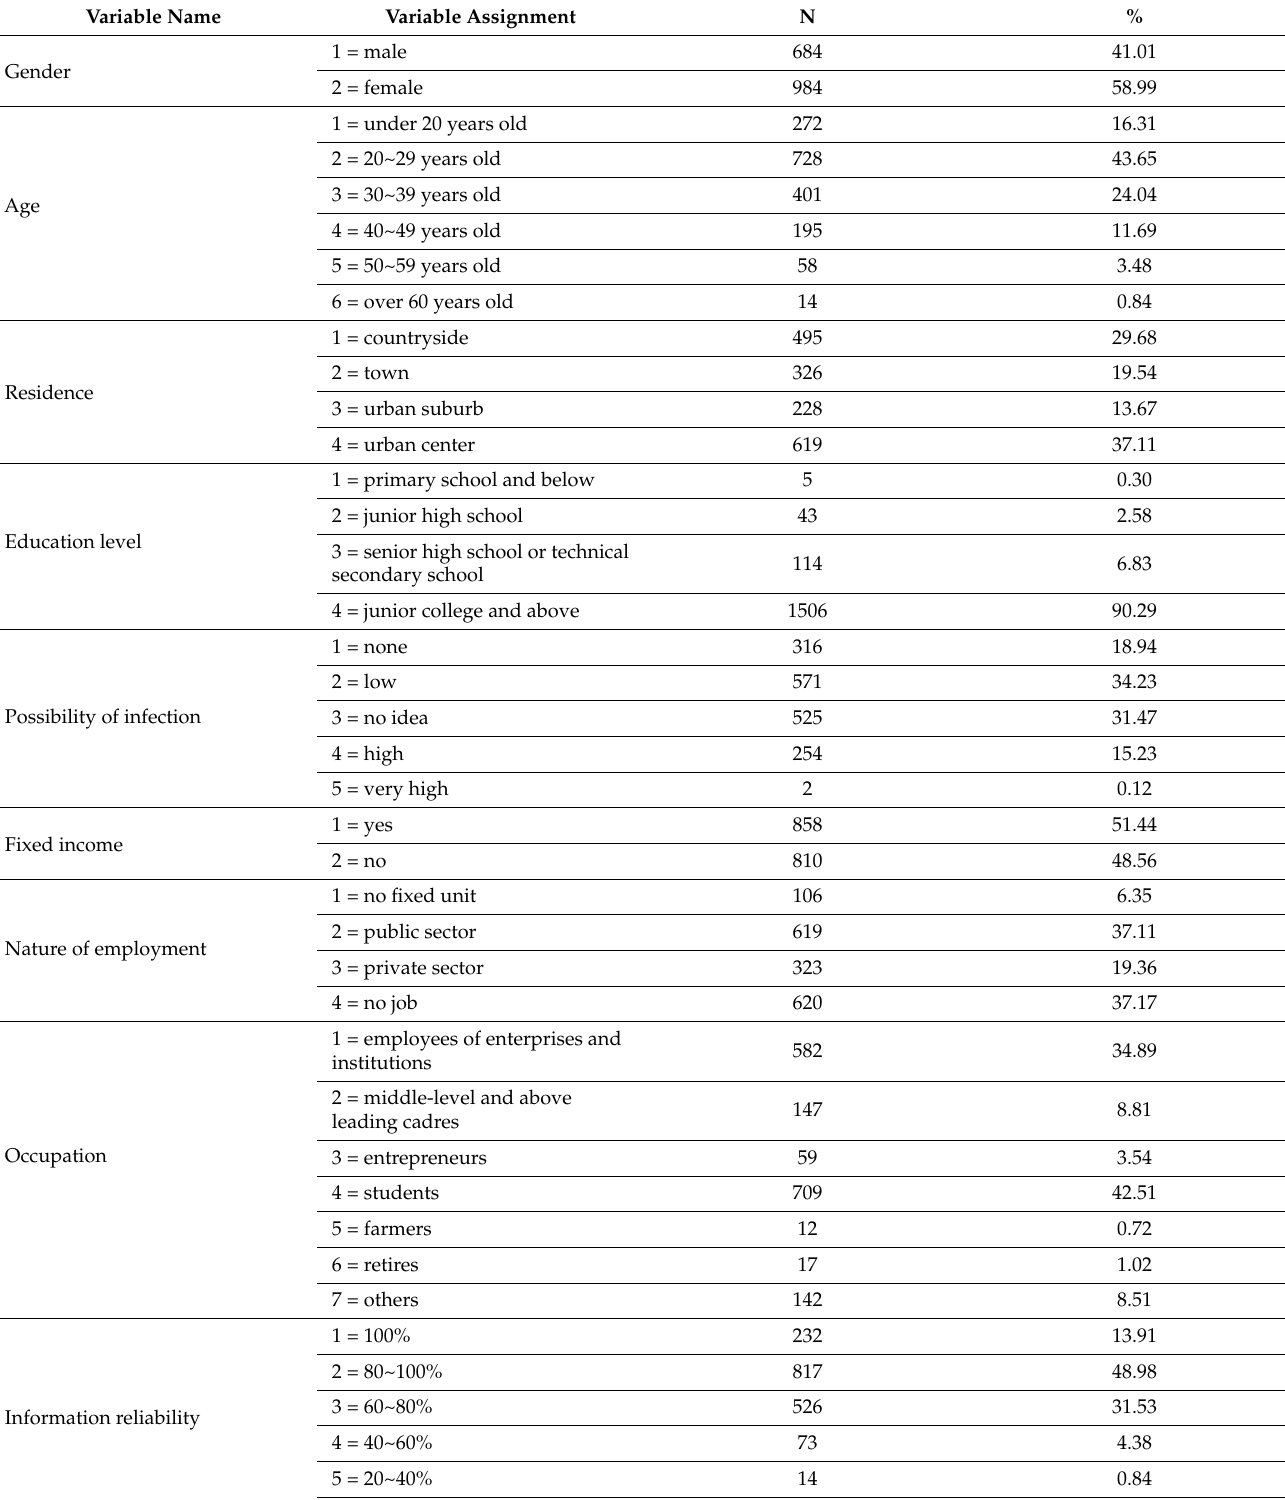
Table 1. Descriptive statistics of the